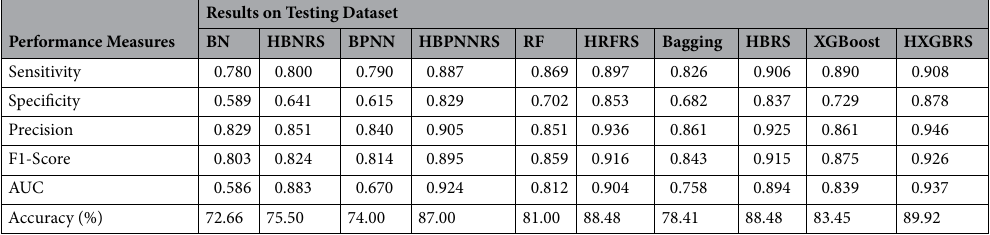
Table 5. Performance comparison of various base, ensemble and hybrid landslide prediction models on testing dataset using statistical parameters based on confusion matrix.